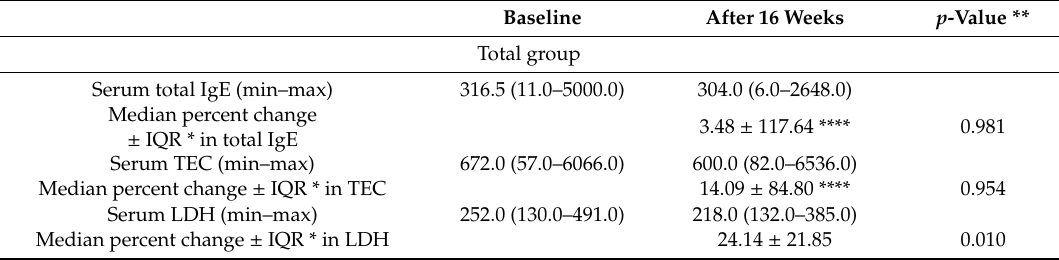
Table 4. Change in laboratory test after